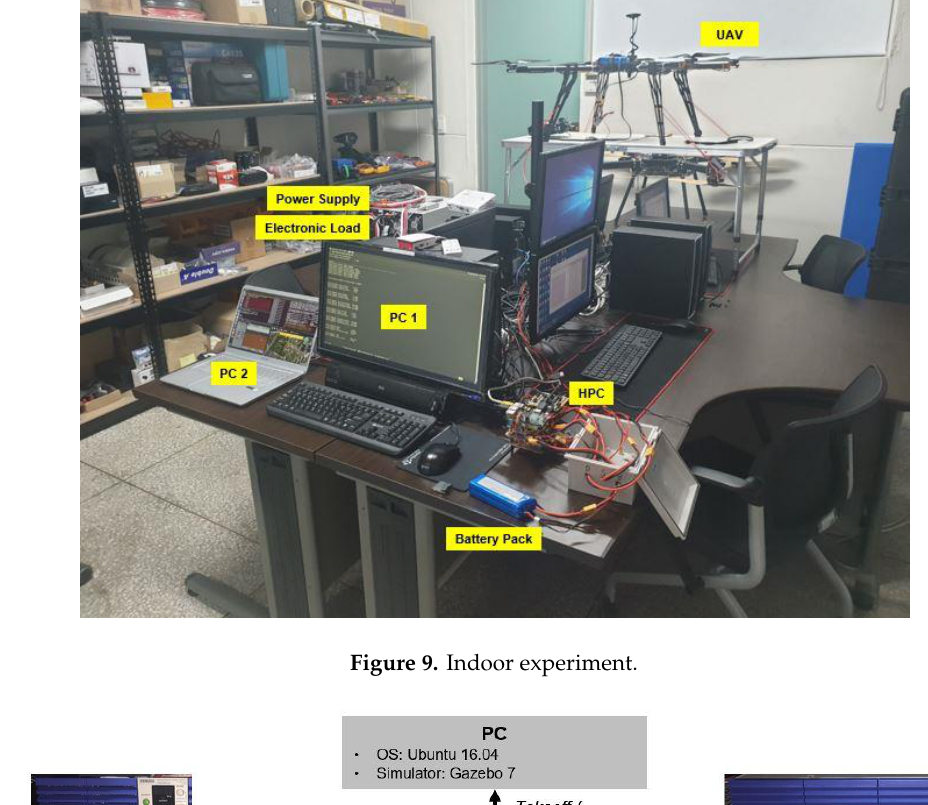
Figure 9. Indoor experiment.